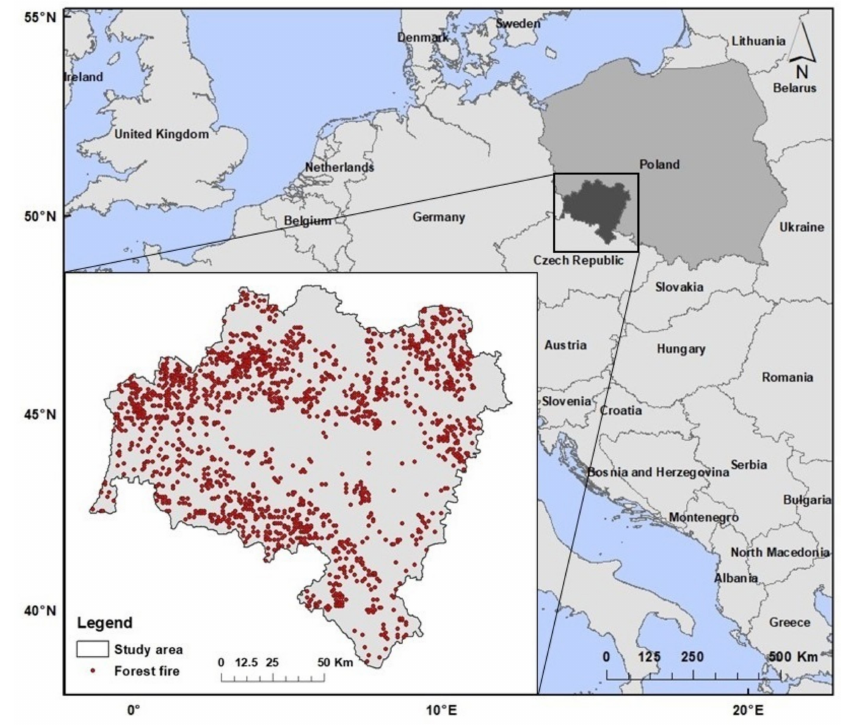
Figure 1. Study area: the Lower Silesian Voivodeship of